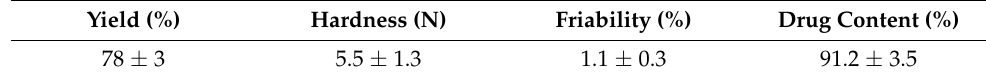
Table 1. The physical characteristic of obtained pellets together with the yield of the pelletization process.